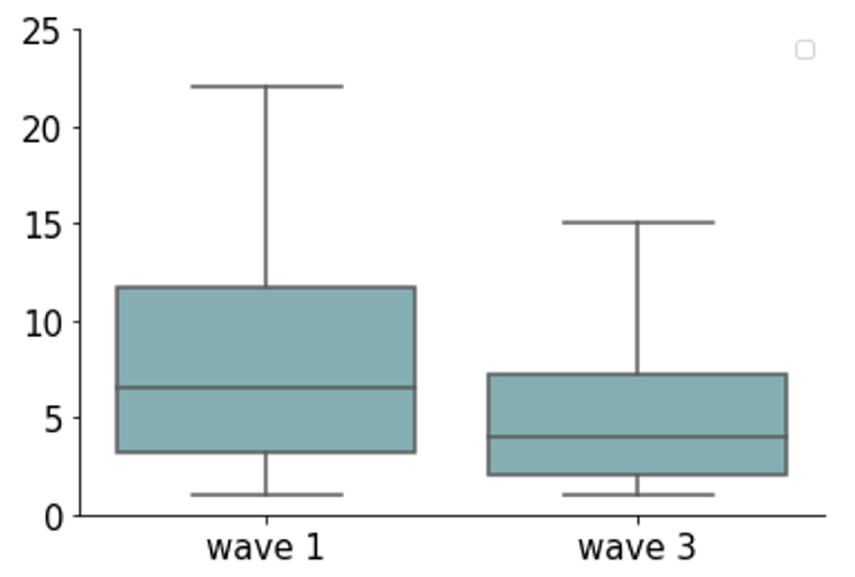
Figure 4. DOT of COVID-19 patients in the third wave compared to the first wave. DOT, days of treatment; p =